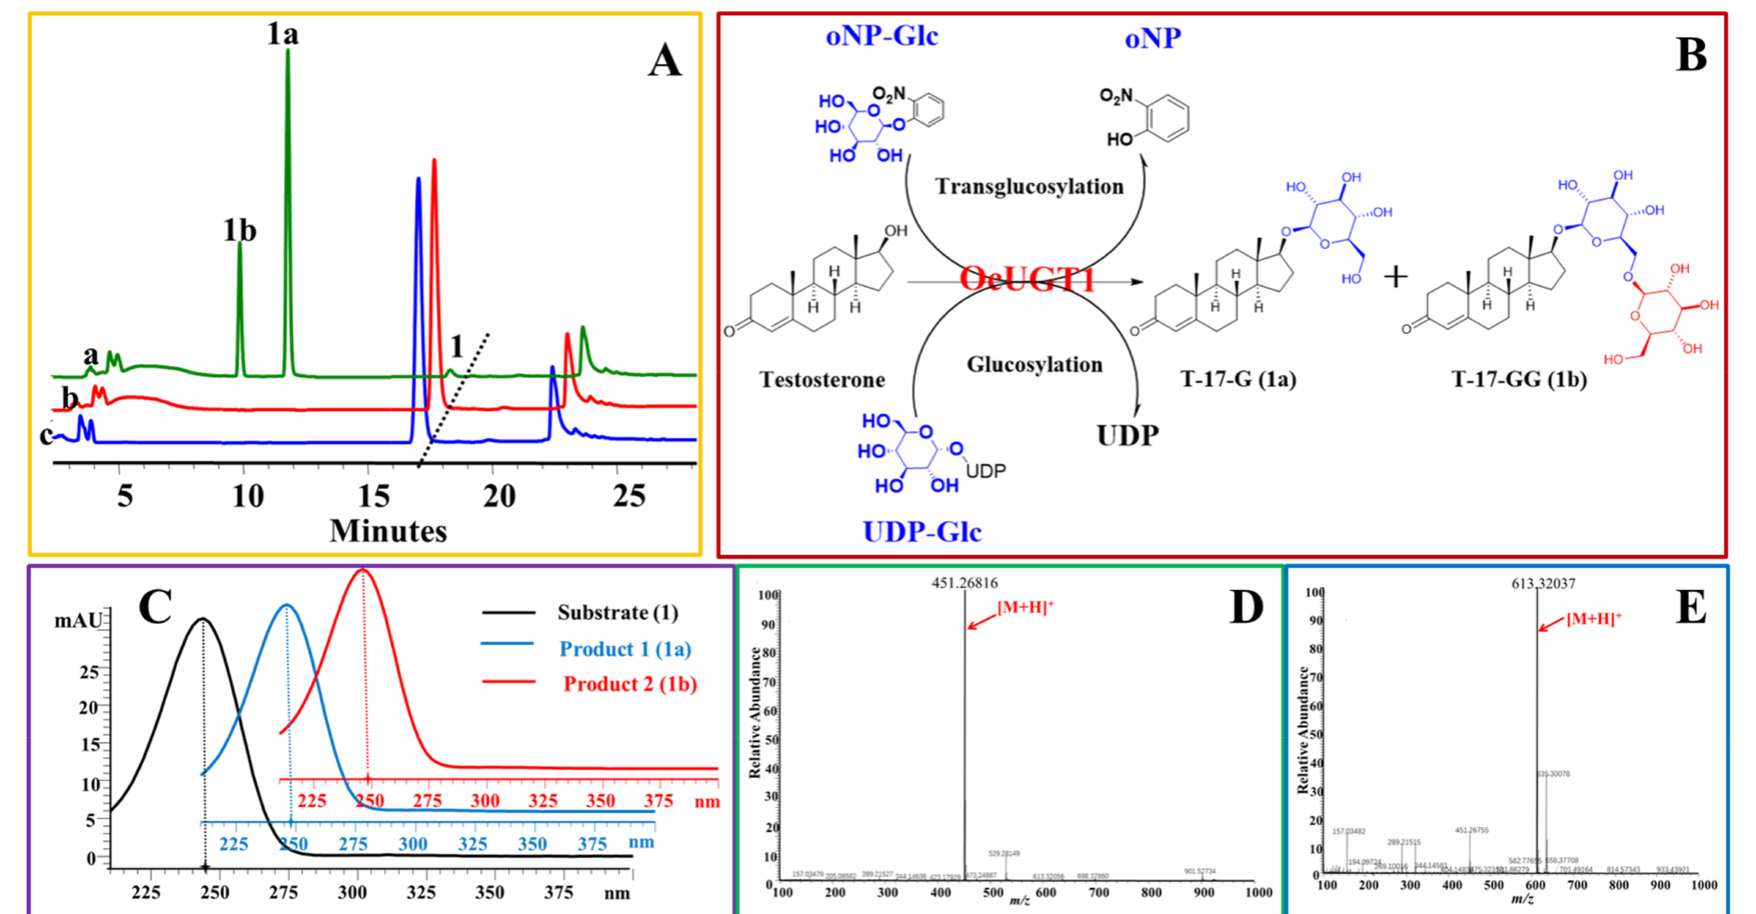
Figure 1. OcUGT1-catalyzed glucosylation of testosterone ( 1 ). ( A ) HPLC profiles of testosterone ( 1 ) glucosylation. ( a ) the reaction mixture of testosterone ( 1 ) with the purified OcUGT1; ( b ) the reaction mixture of testosterone ( 1 ) without the purified OcUGT1; ( c ) the authentical standard testosterone ( 1 ); 1 , 1a, and 1b refer to testosterone ( 1 ) and its mono-glucoside and bioside, respectively. ( B ) OcUGT1-mediated glucosylation of testosterone. ( C ) Ultraviolet (UV) spectra of testosterone ( 1 ) and its glucosides. ( D ) HR-ESI-MS spectrum of T-17-G ( 1a ). ( E ) HR-ESI-MS spectrum of T-17-GG ( 1b